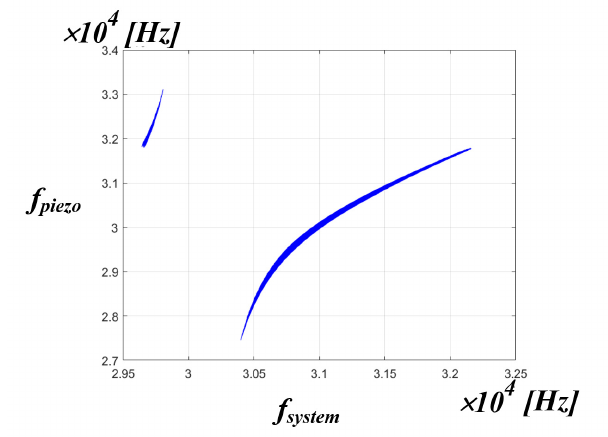
Figure 16. Simulation result of the correlation between the f system and f piezo